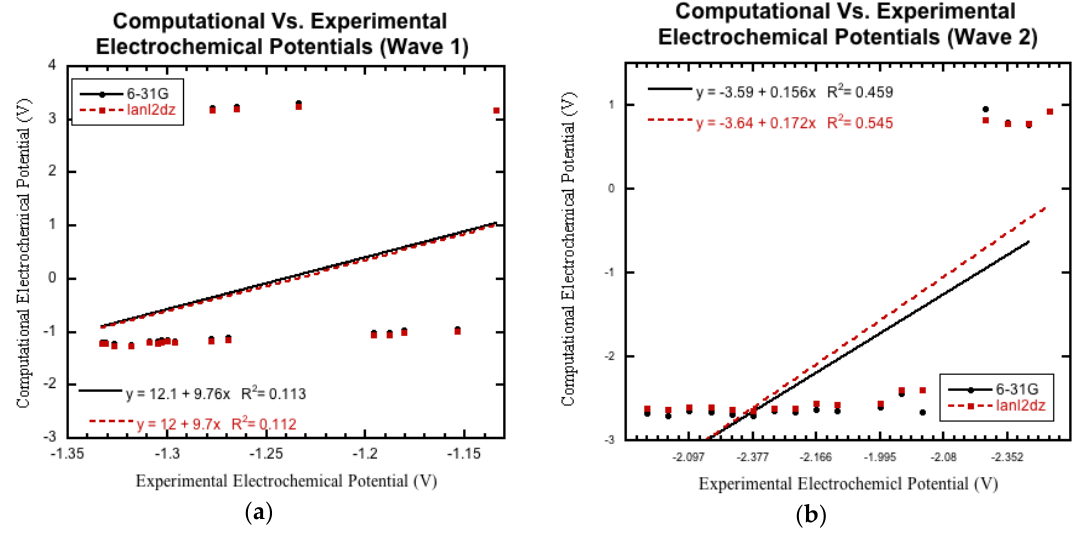
Figure 6. The computationally derived reduction potentials for ( a ) Wave 1 (1st N-oxide reduction) and ( b ) Wave 2 (2nd N-oxide reduction) compared to the previously reported experimentally measured data [27]. The basis set for lanl2dz is shown in red and 6-31g basis set is shown in black. Derivative C3 is excluded.